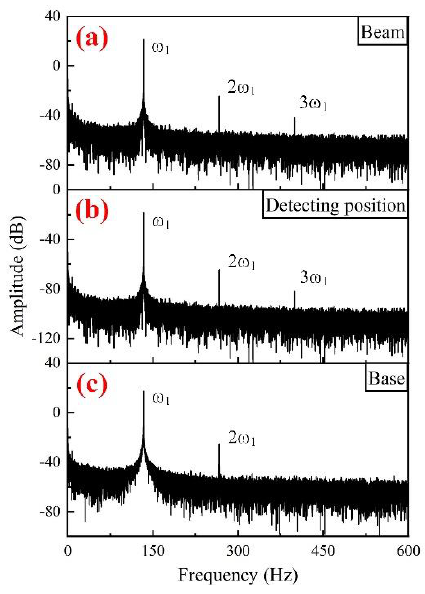
Figure 9. Response spectrogram of CMF double-beam coupled vibration model without additional mass. ( a ) Channel 1. ( b ) Channel 6. ( c ) Channel 7. Table 5. Resonance frequency (Hz) and amplitude difference